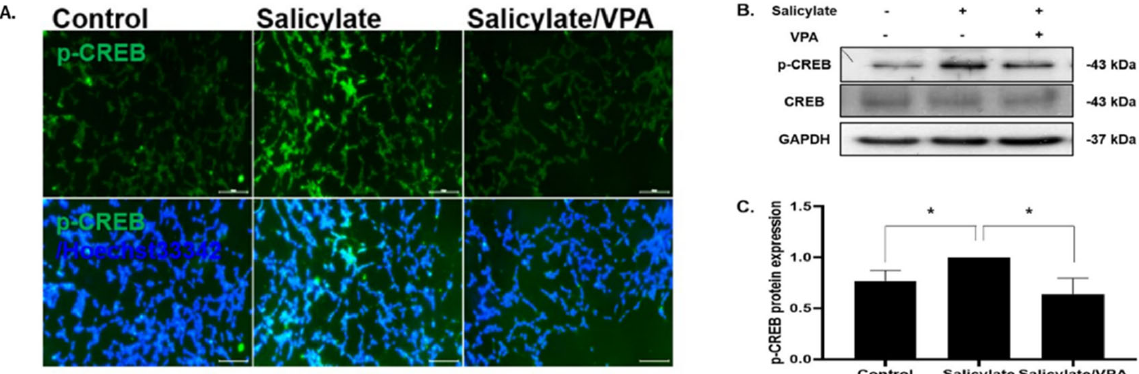
Figure 2. VPA treatment reduces CREB phosphorylation in salicylate-treated SH-SY5Y cells ( A , B ). The levels of phosphorylated CREB (p-CREB) were increased in salicylate-treated SH-SY5Y cells and significantly decreased in VPA-pretreated cells. ( C ). Protein expression was quantified using Image J software and normalized with that of CREB and GAPDH (One-way ANOVA followed by post hoc Tukey test using GraphPad Prism 8.0. * p < 0.05, mean ± SD, n =